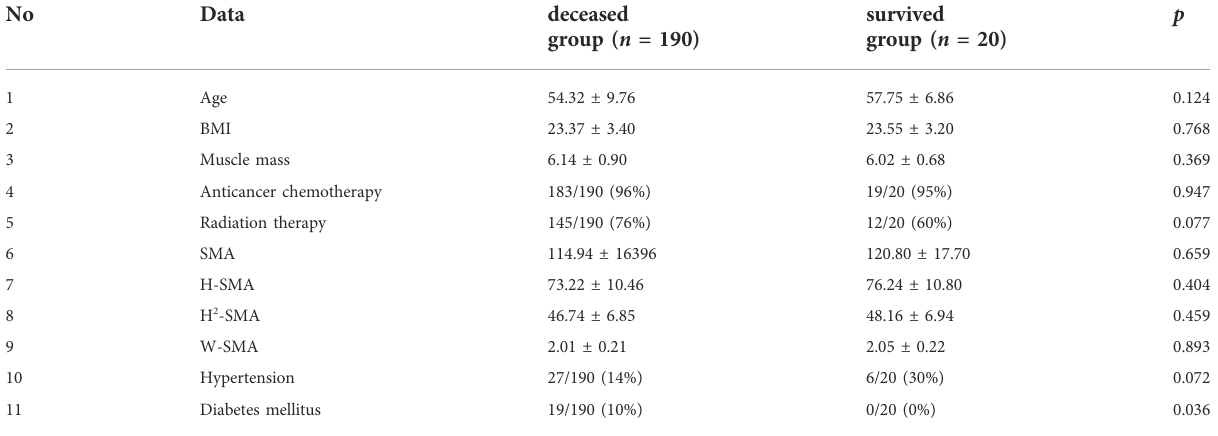
TABLE 2 Statistical summary of clinical features from the survival group ( n = 20, 9.52%) and death group ( n = 190, 90.47%).